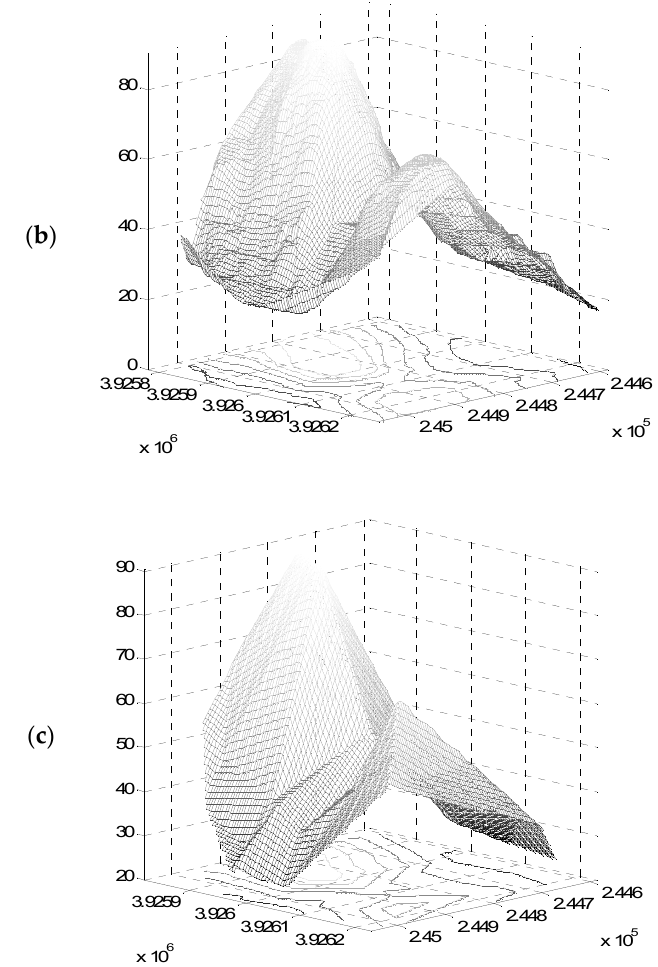
Figure 10. DEMs created for RANSAC distance thresholds t equal to ( a ) 10 − 2 , ( b ) 10 − 6 , and ( c ) 10 − 10 .